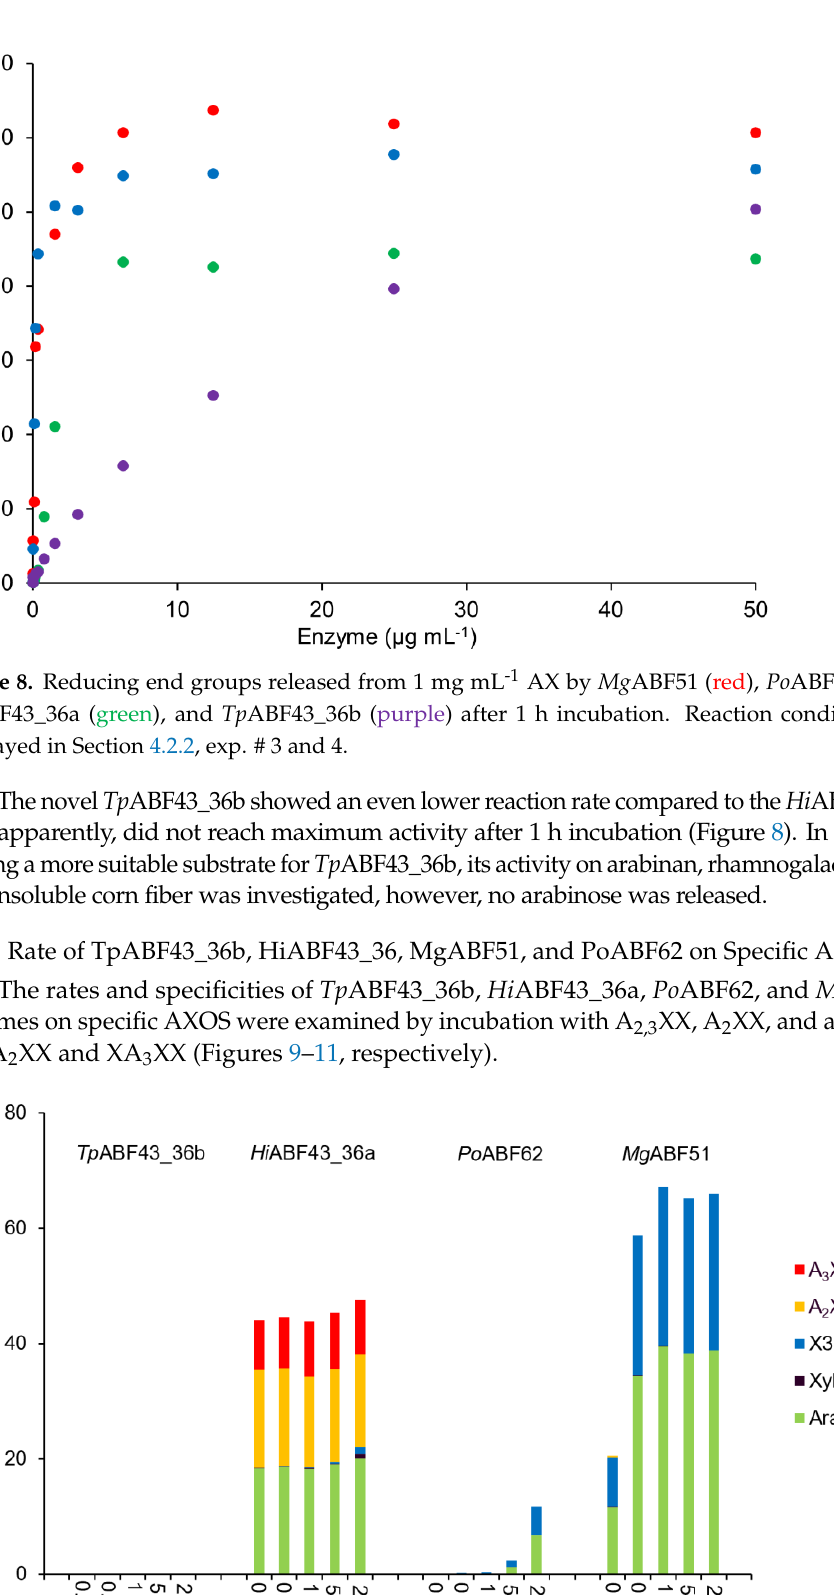
Figure 9. A 2,3 XX product formation (HPAEC) when incubated with Hi ABF43_36a, Tp ABF43_36b, Po ABF62, and Mg ABF51. Arabinose (Ara), xylose (Xyl), xylotriose (X3), A 2 XX, and A 3 XX were de- tected. Reaction conditions are displayed in Section 4.2.2, exp. # 2.